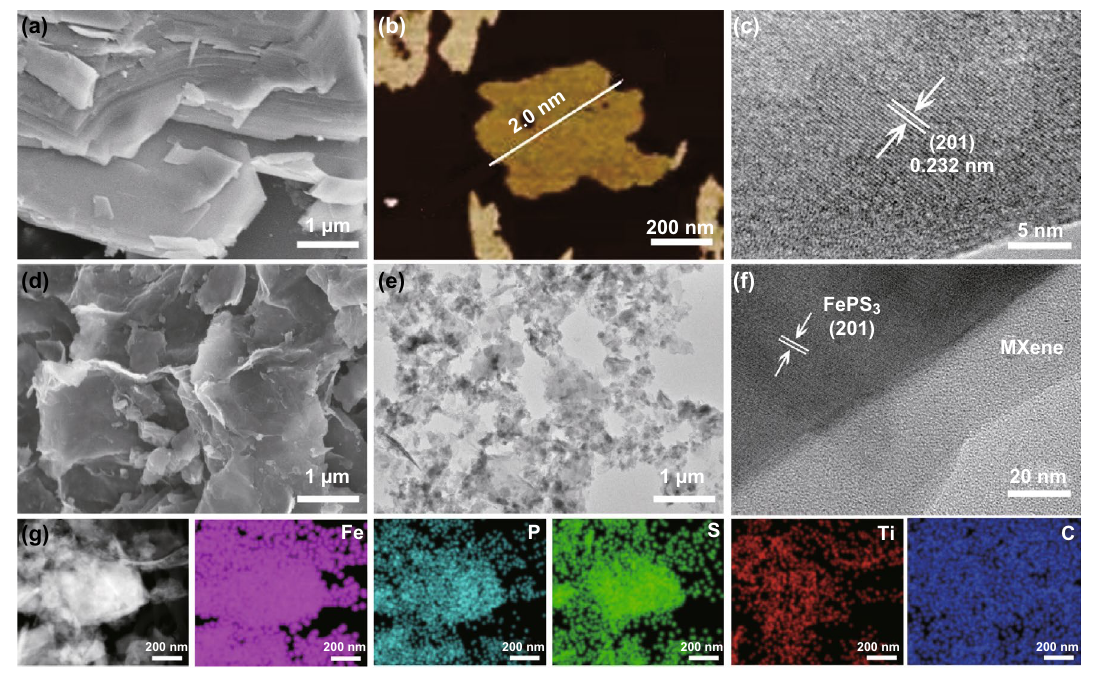
Fig. 2 a SEM image of bulk FePS 3 . b , c AFM and HRTEM images of FePS 3 nanosheets. d–f SEM, TEM, and HRTEM images of FePS 3 @ MXene. g Elemental mapping images of Fe, P, S, Ti, and C